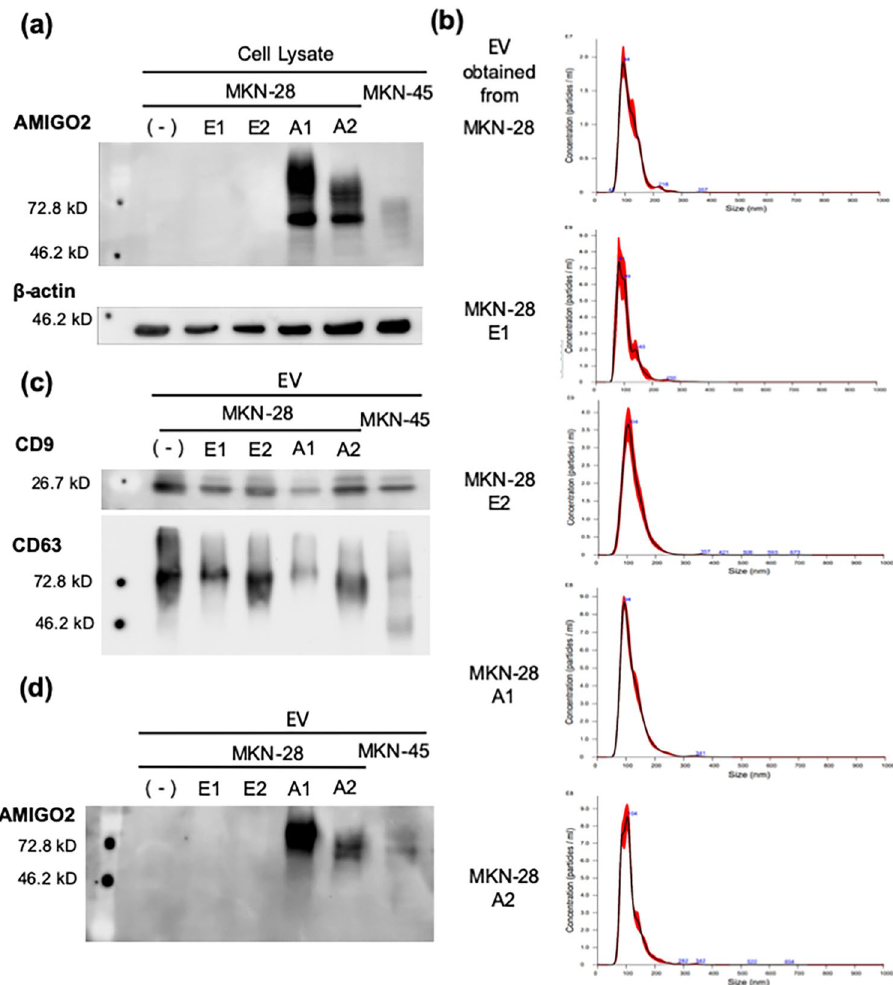
Figure 1. AMIGO2 was present in EVs derived from AMIGO2-overexpressing MKN-28 cells. ( a ) AMIGO2 was only detected in AMIGO2-overexpressing cells (MKN-28 A1 and A2) and MKN-45, as determined by western blotting. Full-length blots were presented in Supplementary Fig. S1. ( b ) EV size was determined via nanoparticle tracking analysis. ( c ) CD9 and CD63 expression was detected by western blotting. Full-length blots were presented in Supplementary Fig. S2. ( d ) AMIGO2 present in EVs obtained from AMIGO2-overexpressing cells (A1 and A2) and MKN-45 cells, as determined by western blotting. Full-length blots were presented in Supplementary Fig.